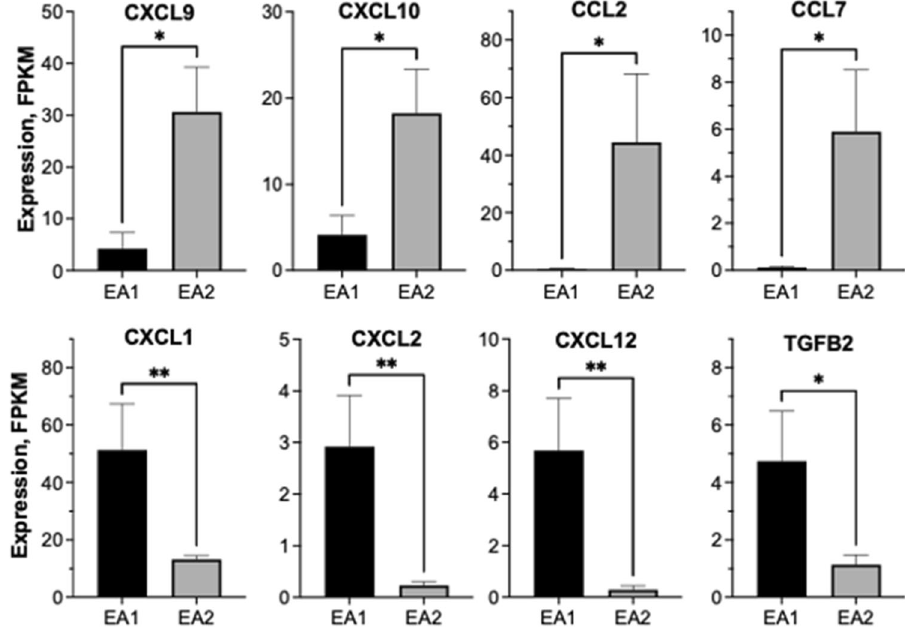
Fig. 5 Distinct baseline chemokine expression patterns in EA1 and EA2 orthotopic tumors. EA1 and EA2 tumors were established in C57BL/ 6 mice in which GFP was ubiquitously-expressed in all cell types (see “ Methods ” ). After ~3 weeks, the left lung lobes from the tumor bearing mice ( n = 5 for each cell line) were dissociated into single-cell suspensions and submitted to fl ow sorting to collect the GFP-negative tumor cells. RNA was puri fi ed from the sorted cells and submitted to RNAseq. The data show the mRNA expression in FPKM (mean and SEM) where * and ** indicate p values <0.05 and <0.01, respectively.